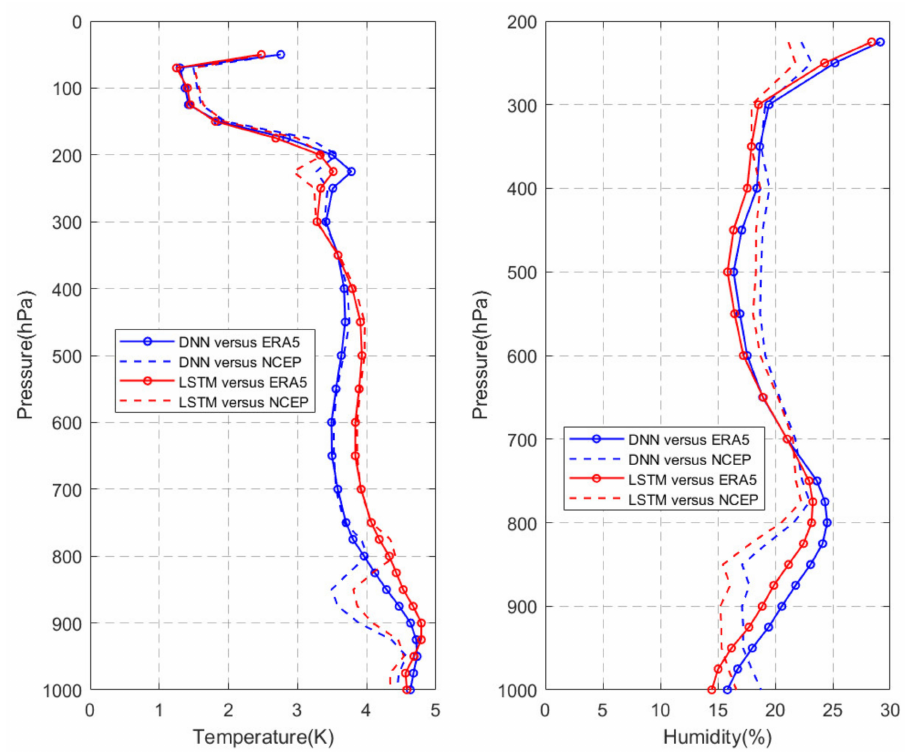
Figure A4. The retrieval RMSEs of the DNN-based model and the LSTM-based with respect to ERA5 and NCEP reanalysis data over land in September